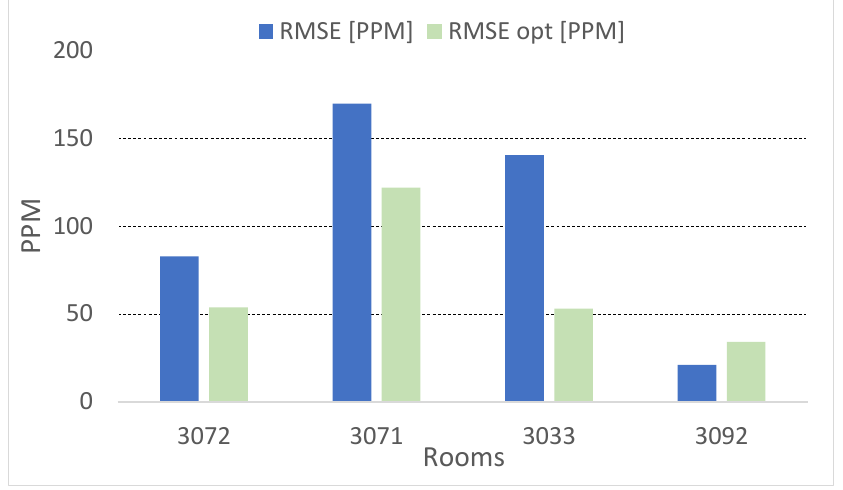
Figure 12. Root-mean-square error of the CO 2 concentration: comparison calibrated model vs. optimized model.